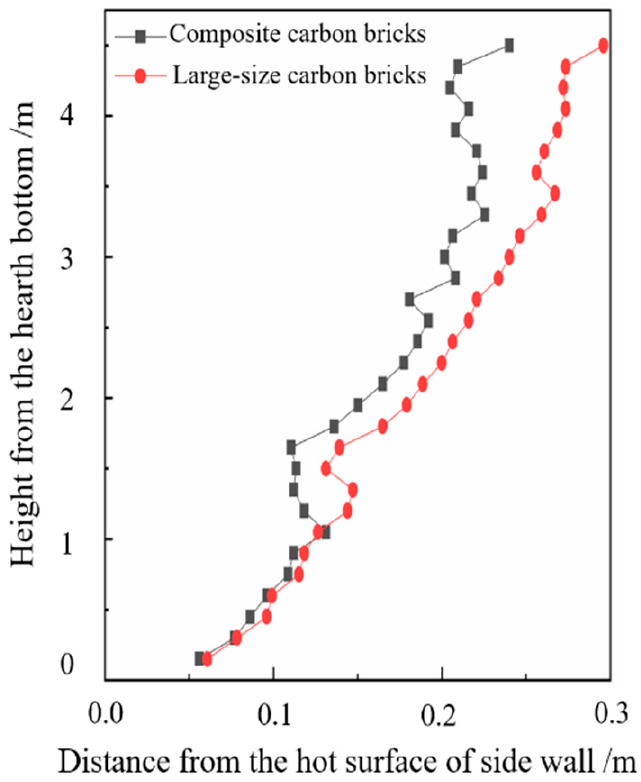
Figure 14. 1423 K isotherm line on the xz cross section of hearth sidewall through the taphole.